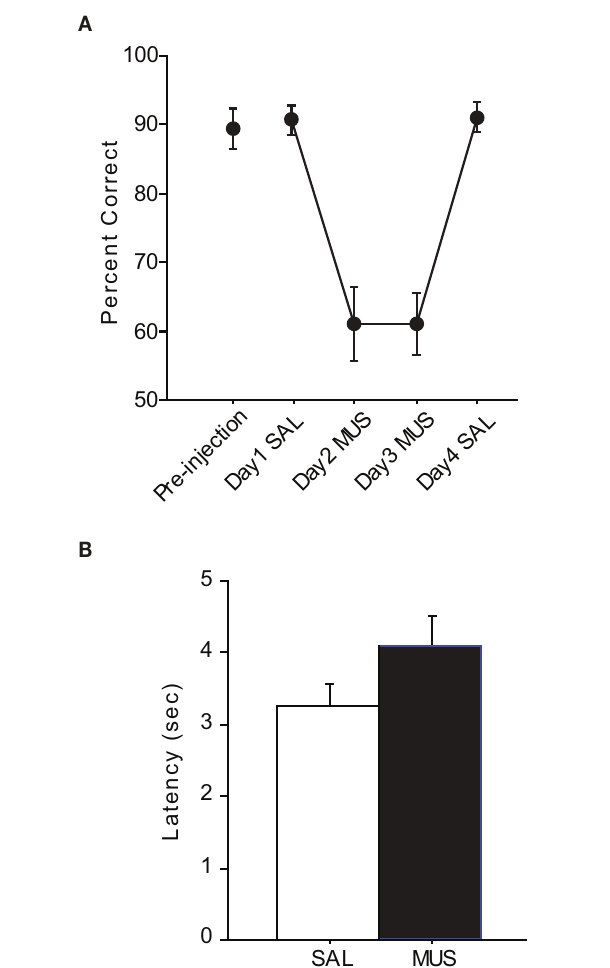
FIGURE 3 | Performance in the pVCRS task. (A) Rats with MUS infusions in the hippocampi were severely impaired compared to the SAL conditions. (B) Average latency measures were not significantly different between SAL and MUS conditions. All graphs show mean ± s.e.m.